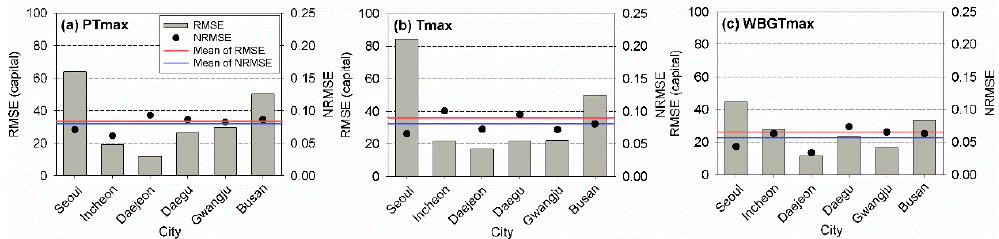
Figure 5. Root-mean-square error (RMSE) and normalized RMSE of the observed and estimated annual total mortalities for ( a ) PTmax, ( b ) Tmax, and ( c ) WBGTmax for the six cities during the training period (2000–2016).